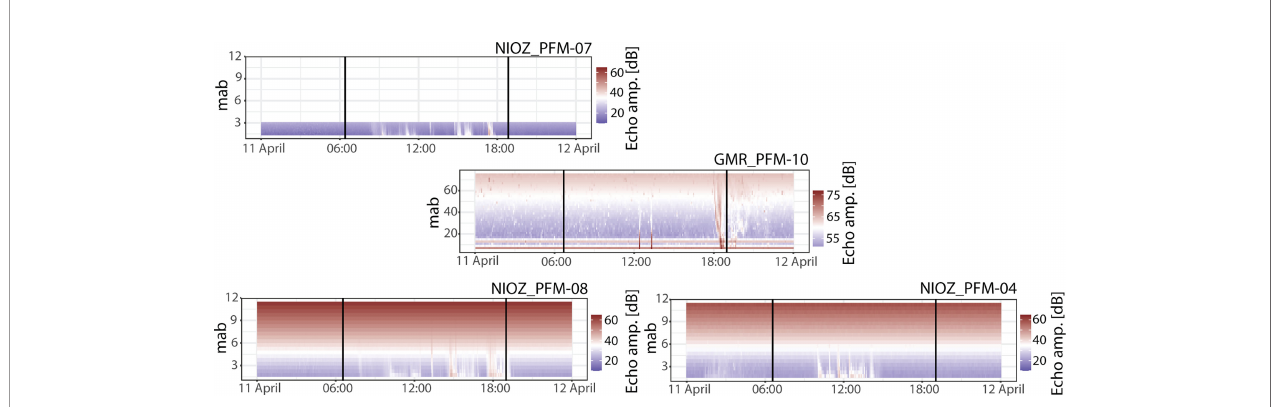
FIGURE 8 | Time series of acoustic backscatter (converted to dB) in the lower metres or tens of metres above the seabed (mab) recorded with Nortek Aquadopp pro fi lers (on NIOZ_PFM-04, -07 and -08) and the RDI Workhorse ADCP (on GMR_PFM-10) in the southern part of the sensor array, showing the vertical extent of the sediment plume and particle swarms above the seabed. The two black lines in the fi gures represent the start and the end time of the dredging. The arrangement of the time series graphs corresponds with the geographical arrangement of the sensor platforms. Note the different scale of the vertical axis for platform GMR_PFM- 10. The range-dependent gradual increase in background echo amplitude level is caused by acoustic loss corrections for spreading and absorption, which amplify the raw signal with increasing distance from the transducer (Eq.1). Since the acoustic absorption is frequency dependent, this increase is more pronounced for NIOZ_PFM-04, -07, and -08 (Nortek Aquadopp with 2 MHz), compared to GMR_PFM-10 (RDI ADCP with 300 kHz).